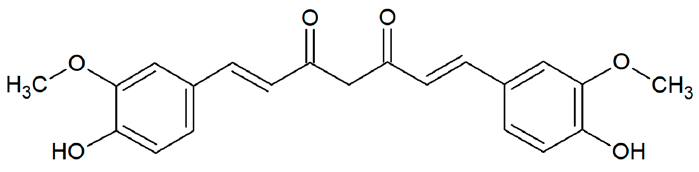
Figure 1. Chemical structure of curcumin.